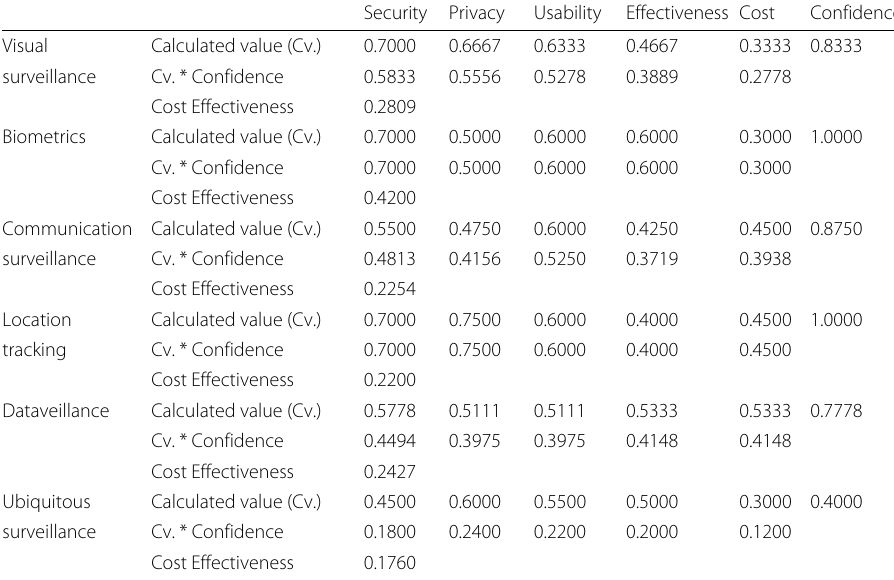
Table 10 Perception of experts in utility networks